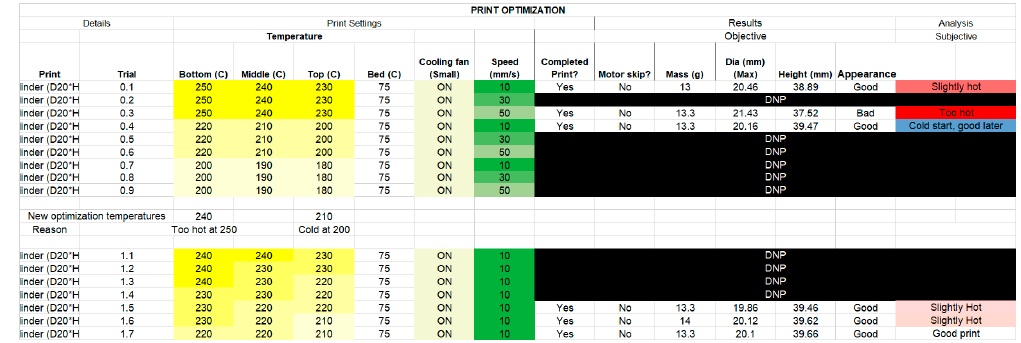
Figure A1. Print optimization with small-fan cylinder.